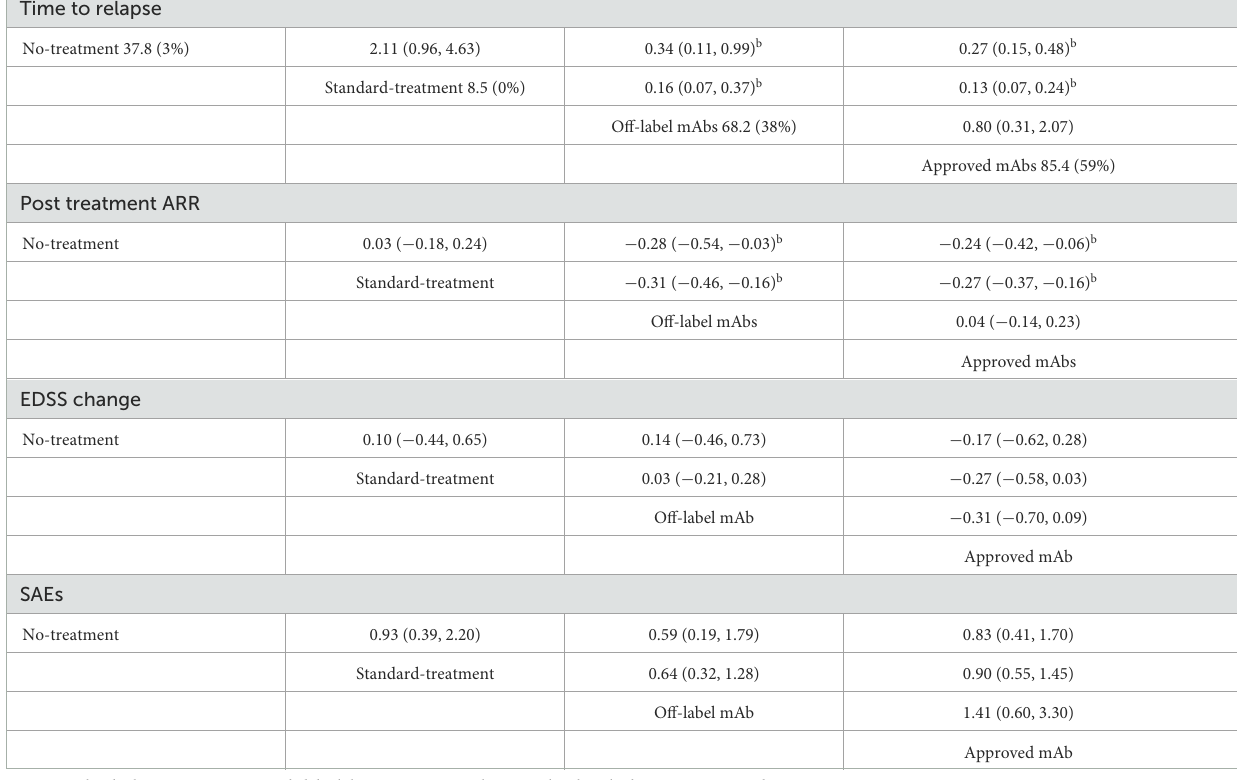
TABLE 2 Hazard ratio and 95% confidence interval of network meta-analysis of time to clinical outcomes (above gray diagonal line) a